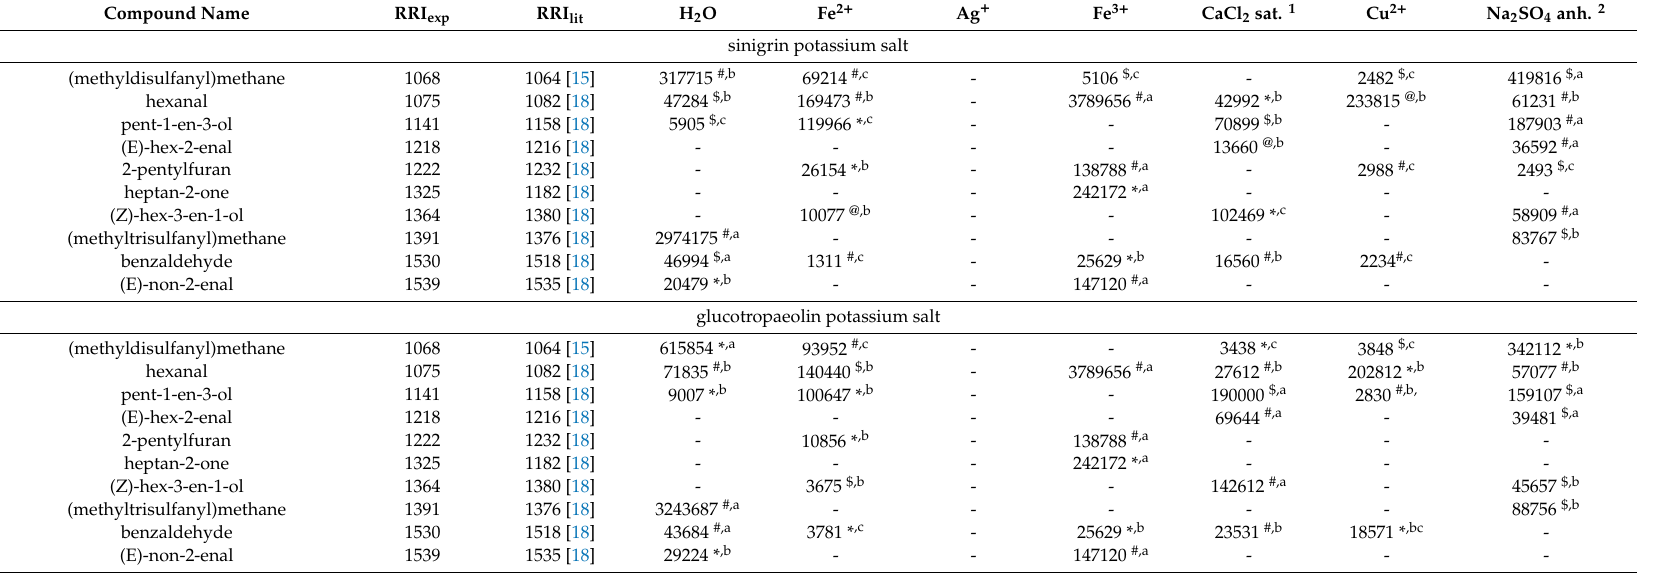
Table 2. Miscellaneous volatile compounds from kohlrabi tissue.